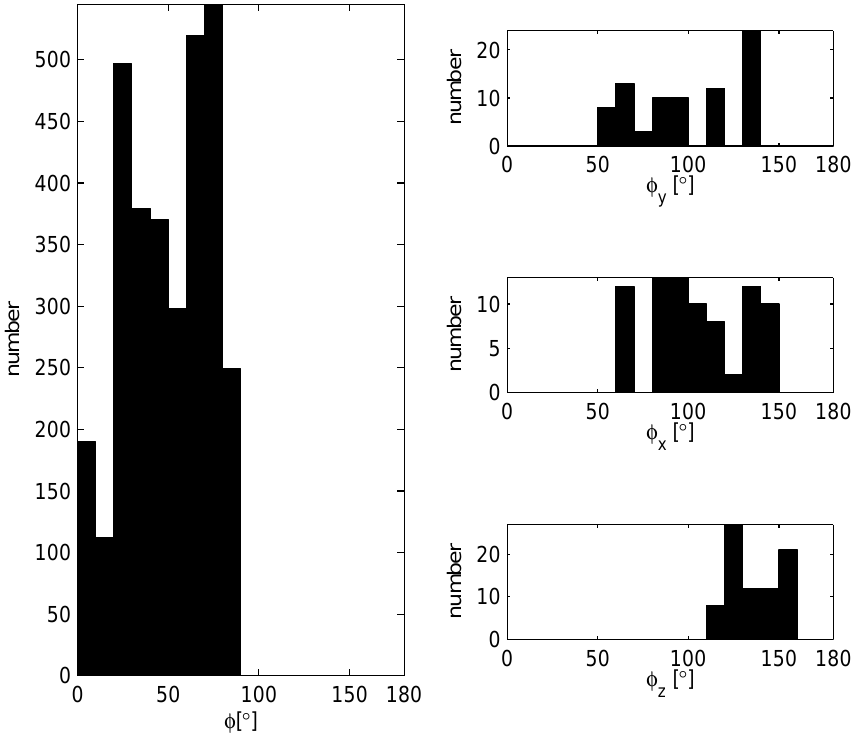
Fig. 7. The histograms of the crossing angles of every two slants in the chosen voxels in Fig. 5 (right) at station Schleswig. The corresponding cutting angles with axis vector e x , e y , e z and a spread of dφ x = 82 . 67 ◦ , dφ y = 88 . 41 ◦ , dφ z = 45 . 29 ◦